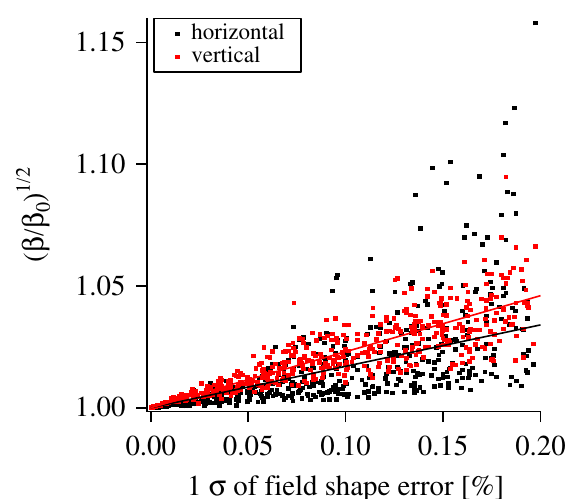
FIG. 8. (Color) Maximum growth of square root of beta func- tions against field shape errors. Straight lines indicate linear